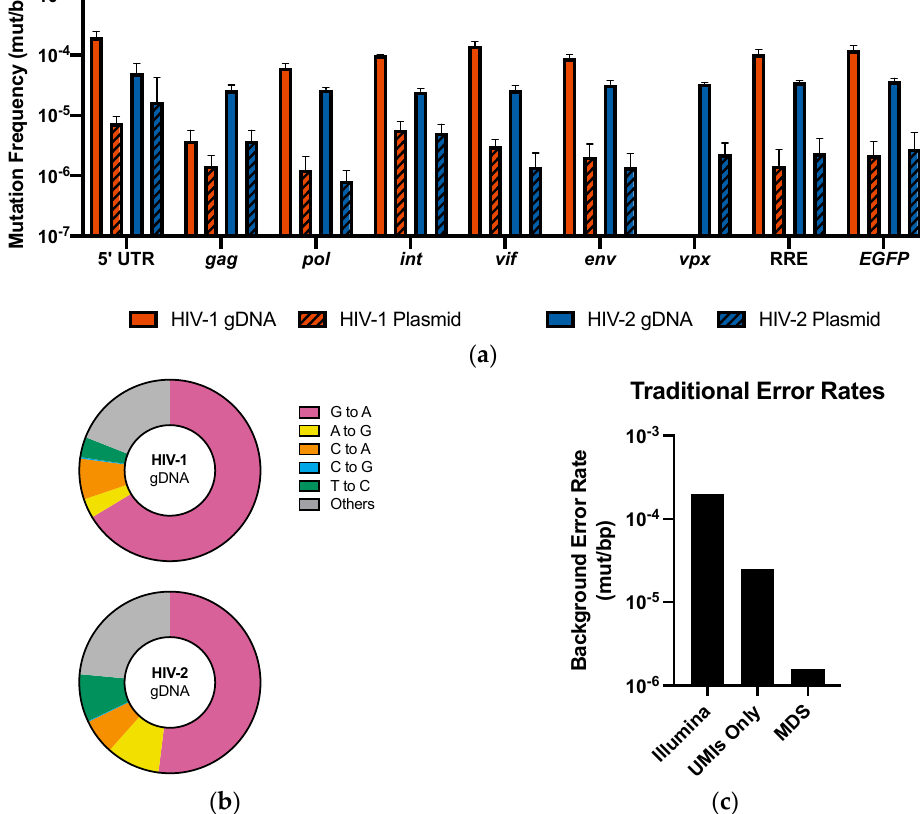
Figure 5. Mutation profile of ROIs in HIV-1 and HIV-2. The ( a ) mutation frequency and ( b ) mutation spectra were calculated for each of the 8 ROIs in HIV-1 and 9 ROIs in HIV-2. Across all ROIs, the mutation frequency was 9.35 × 10 − 5 mut/bp in HIV-1 and 3.14 × 10 − 5 mut/bp in HIV-2. The mutation frequency was significantly higher in gDNA samples than in plasmid samples for HIV-1 and HIV-2 across all amplicons ( p < 0.05 for all). ( c ) Comparison of the background error rates in HIV-1 and HIV-2 plasmids using MDS with error rates previously observed with Illumina sequencing [31] and traditional UMI-based techniques